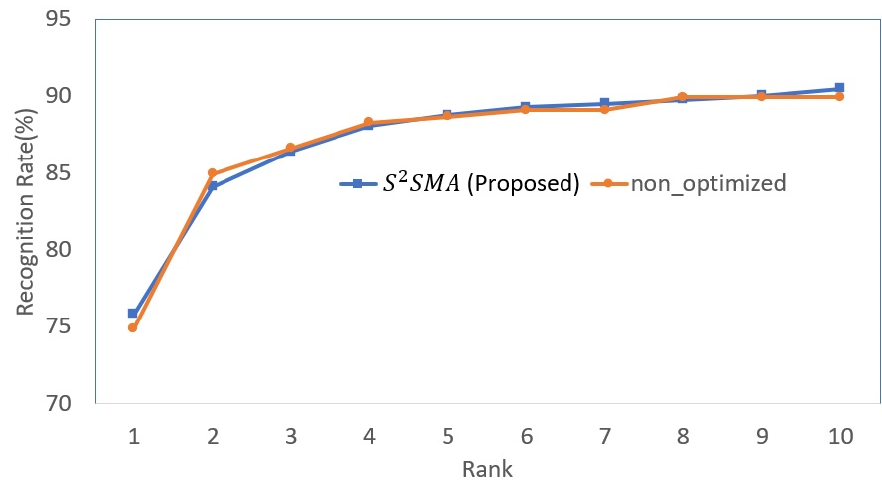
Figure 14. The CMC results of the proposed method as compared with the non-optimized multi- ple-model approach. Table 13. Multiple-model fitness results on CUFSF.